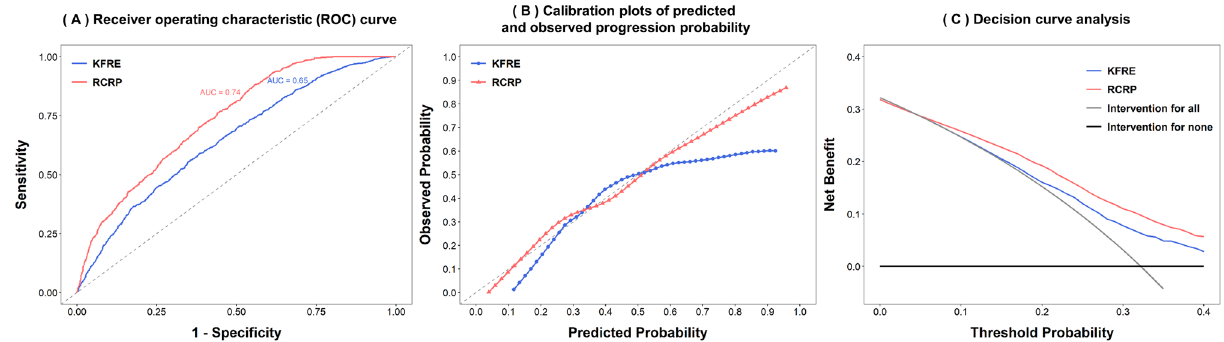
Figure 4. Prediction performance of the proposed renal care responsiveness prediction (RCRP) model compared with the reference model using seven variables based on kidney failure risk estimation (KFRE). ( A ) Receiver operating characteristic curve, ( B ) calibration plots of predicted and observed progression probability, and ( C ) decision curve